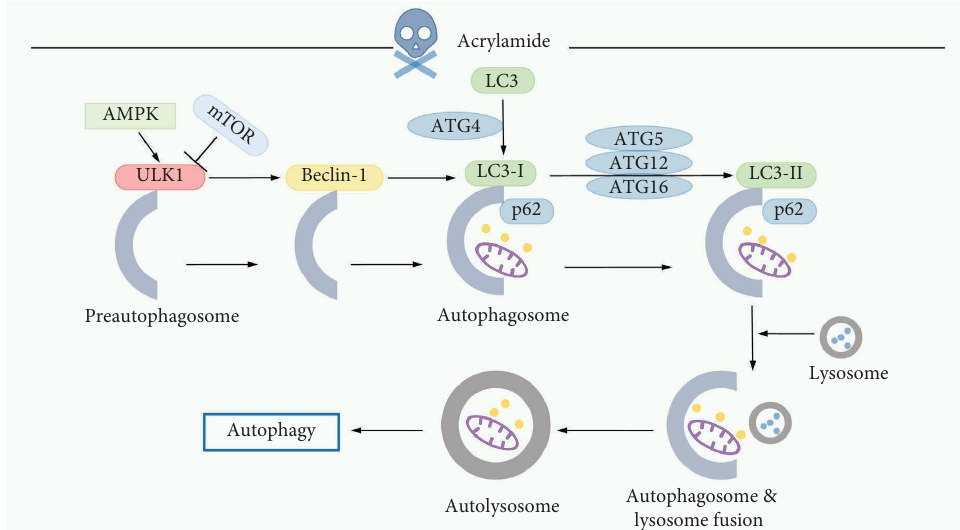
Figure 4: Molecular mechanisms of autophagy pathways in AA-induced